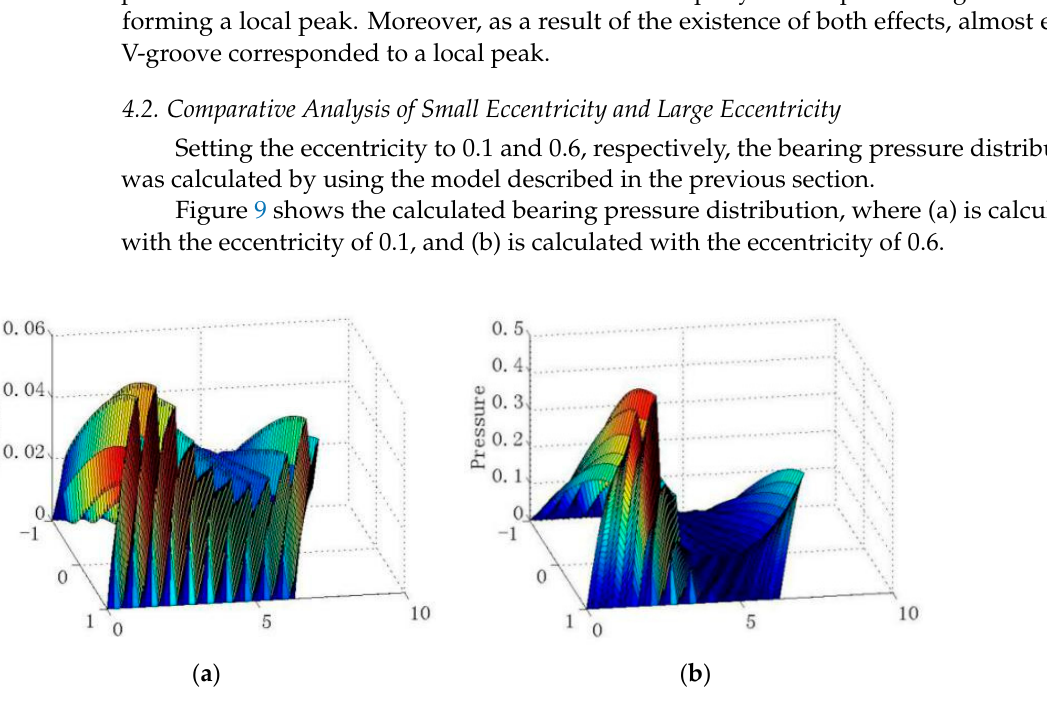
Figure 9. Pressure distributions under different eccentricities: ( a ) Dimensionless pressure distribution calculated with the eccentricity of 0.1; ( b ) Dimensionless pressure distribution calculated with the eccentricity of 0.6.